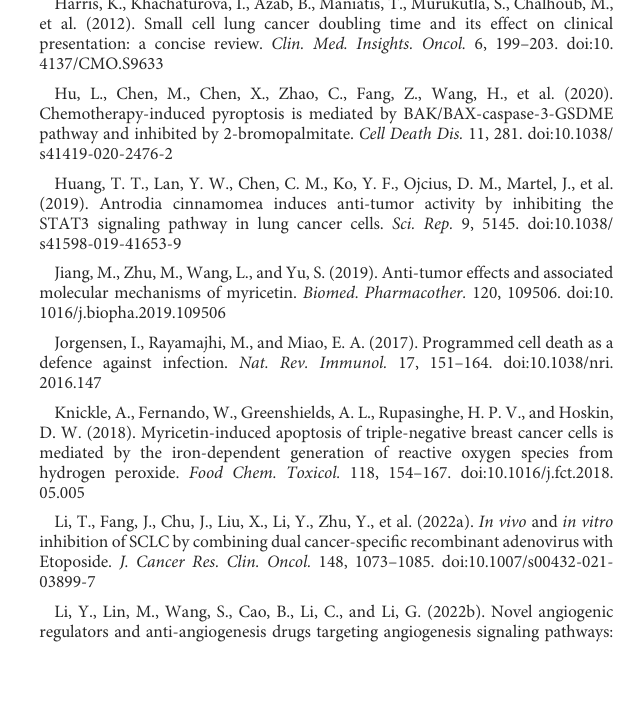
SUPPLEMENTARY FIGURE S1 (A) Half maximal inhibitory concentration (IC50) of Myricetin used for the inhibition of the proliferation of BEAS-2B cells. (B) Western blot analyses of the expression of cleaved caspase-3/4/5/6/7/8 in NCI-H446 cells after myricetin treatment. (C) Myricetin induced pyroptosis in Lewis cell by GSDME. (D) Microscopic imaging of Lewis cells after myricetin